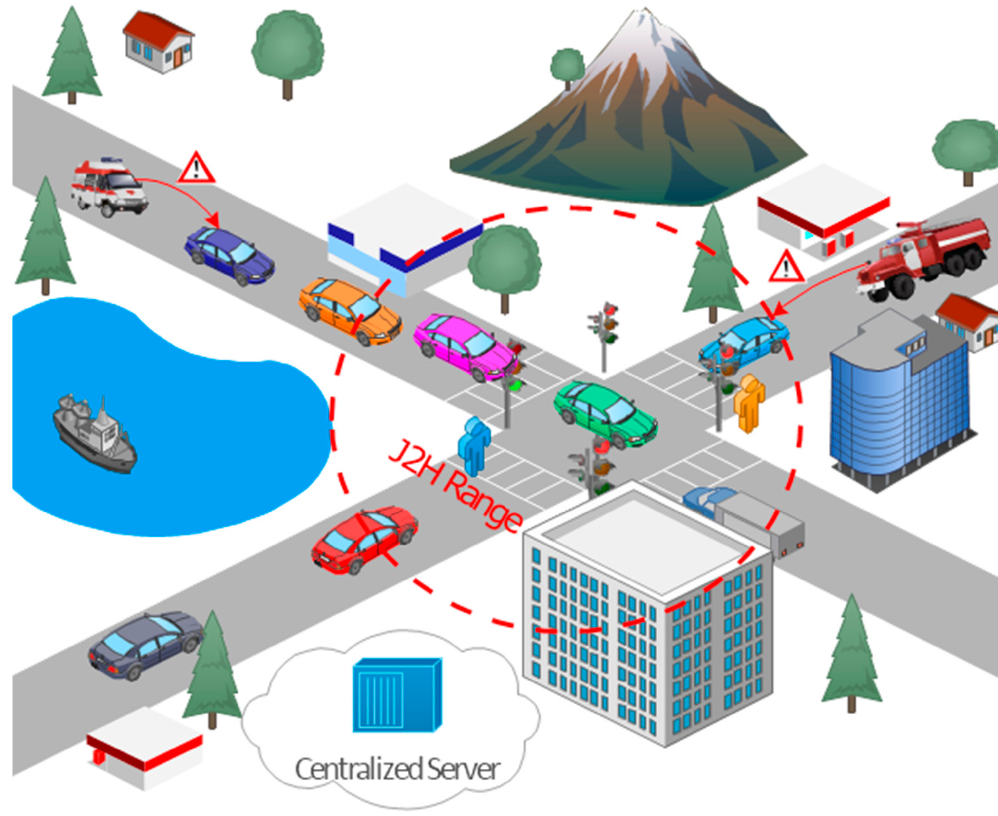
Figure 1. Architecture diagram of J2H approach for emergency vehicles.